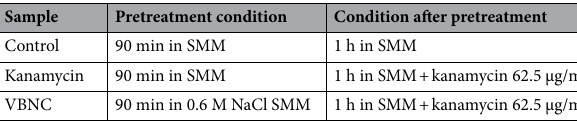
Table 1. List of tested conditions.